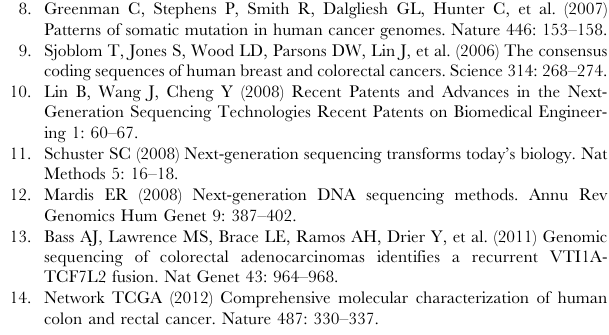
Table S7 SNP genotyping using the Sequenom